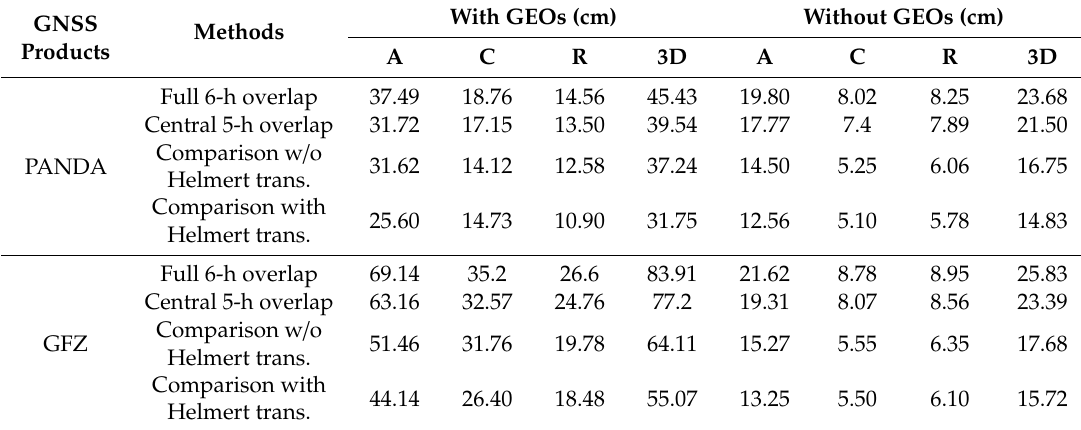
Comparison with Helmert